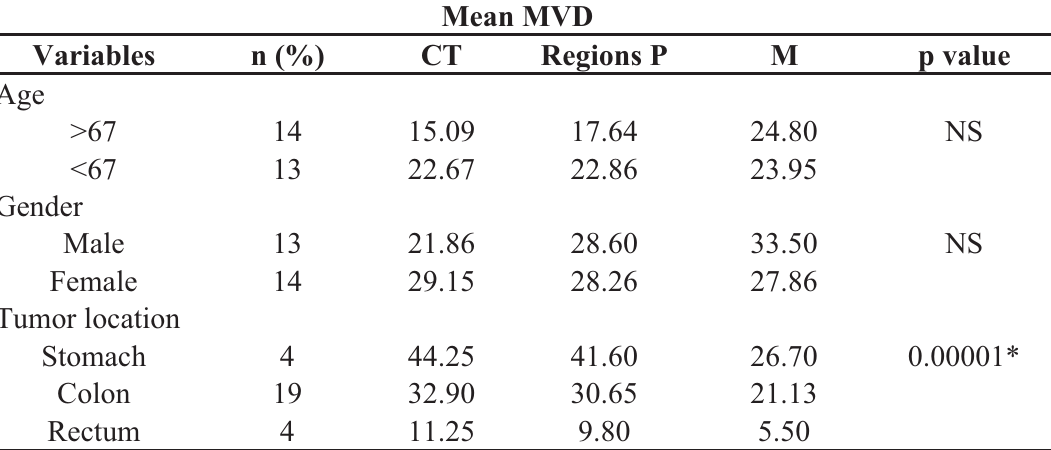
Table 1. Relationship between clinicopathological factors and